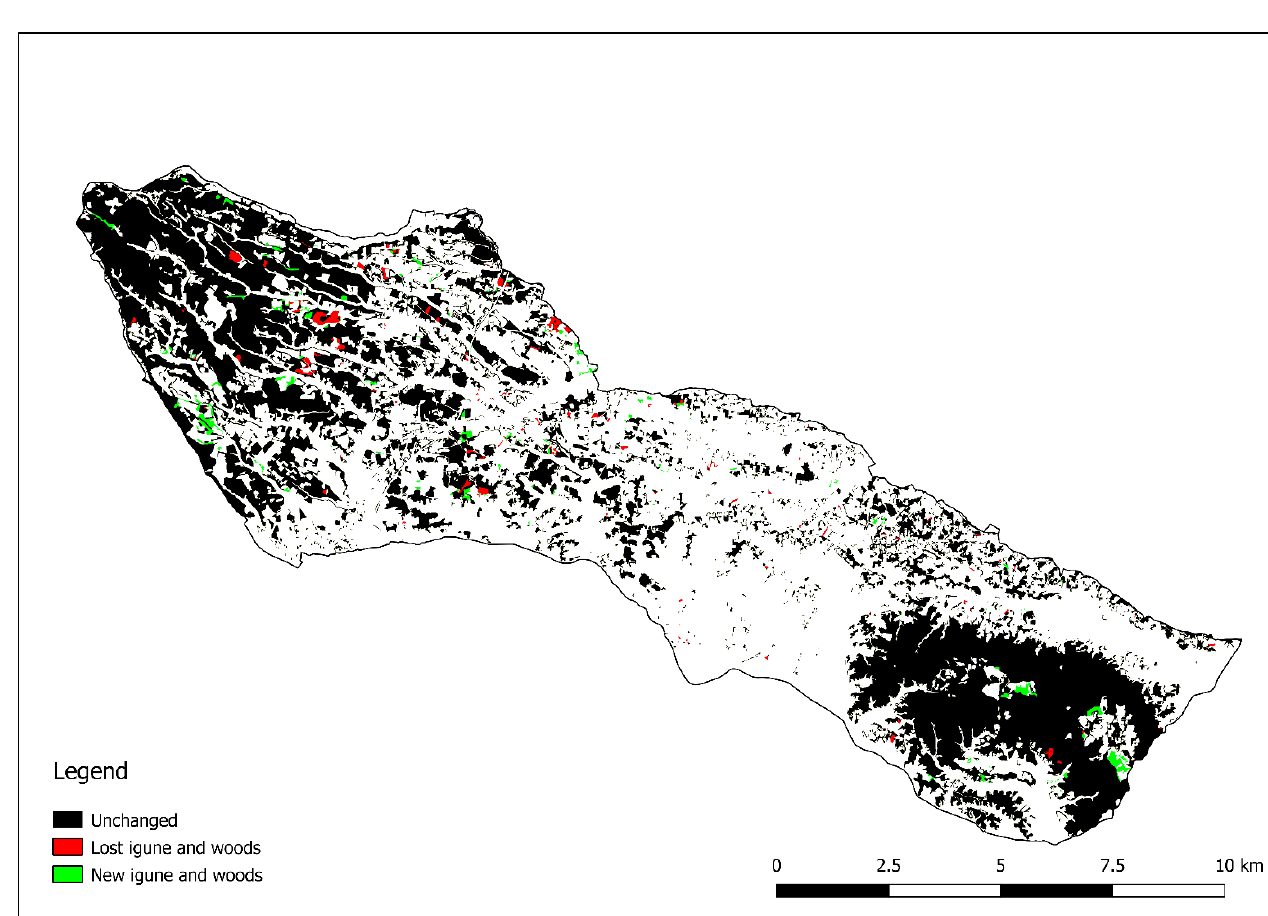
Figure 4. Number, size, and spatial pattern of igune and other small woods remained almost un- changed from 2002 to 2021.